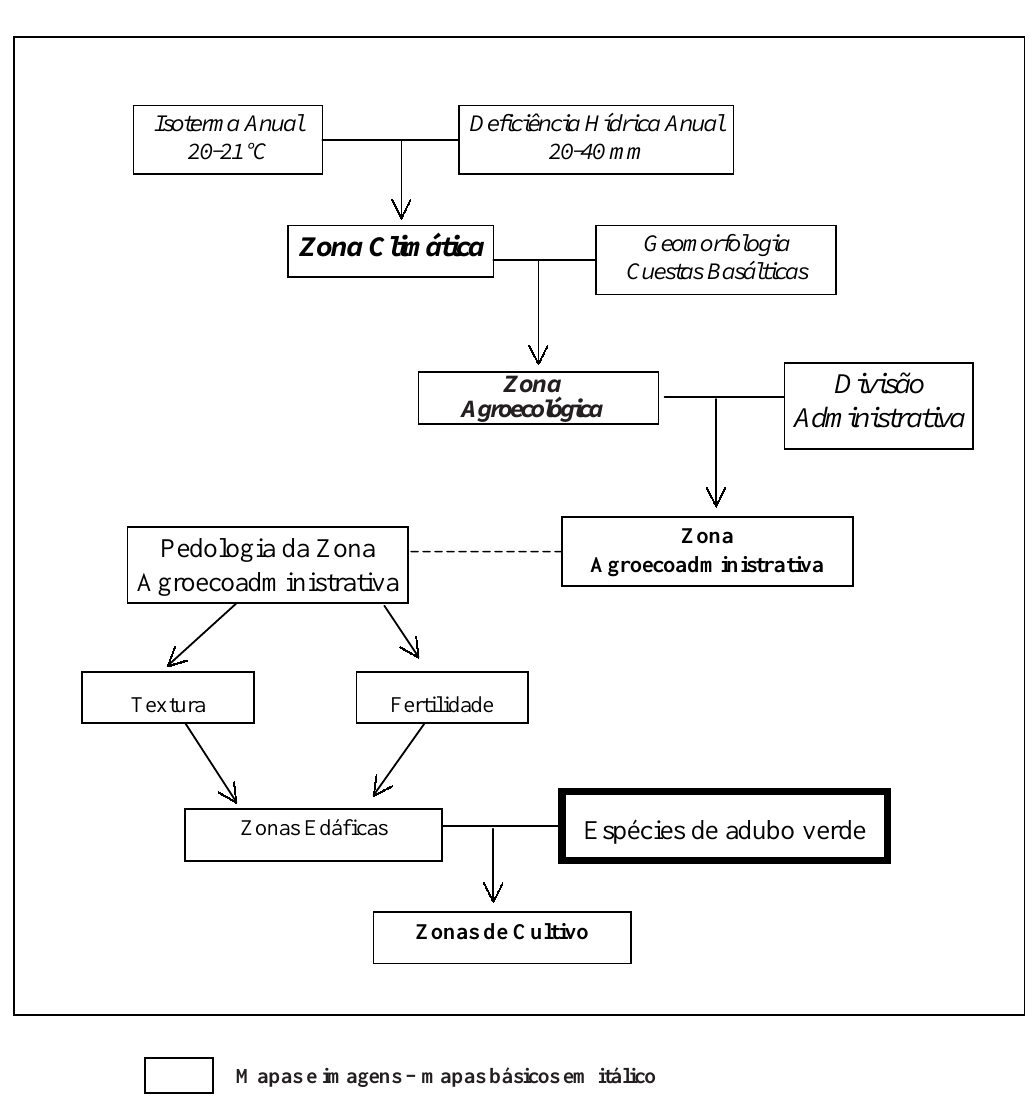
Figura 1. Fluxograma com as etapas da